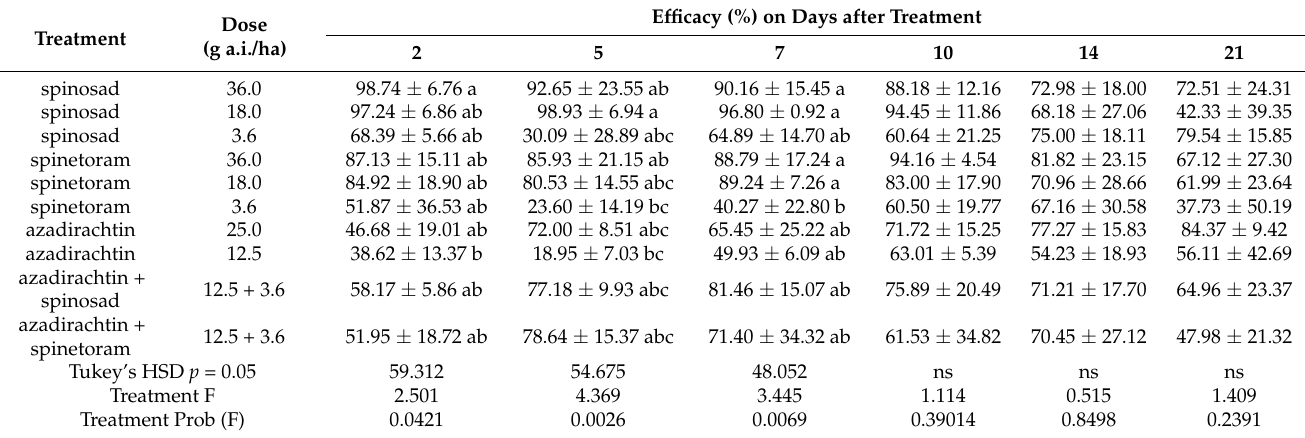
Table 8. Efficacy (%) of insecticide treatments ( ± SE) on Colorado potato beetle larvae in the field trial, Zagreb, 2019.